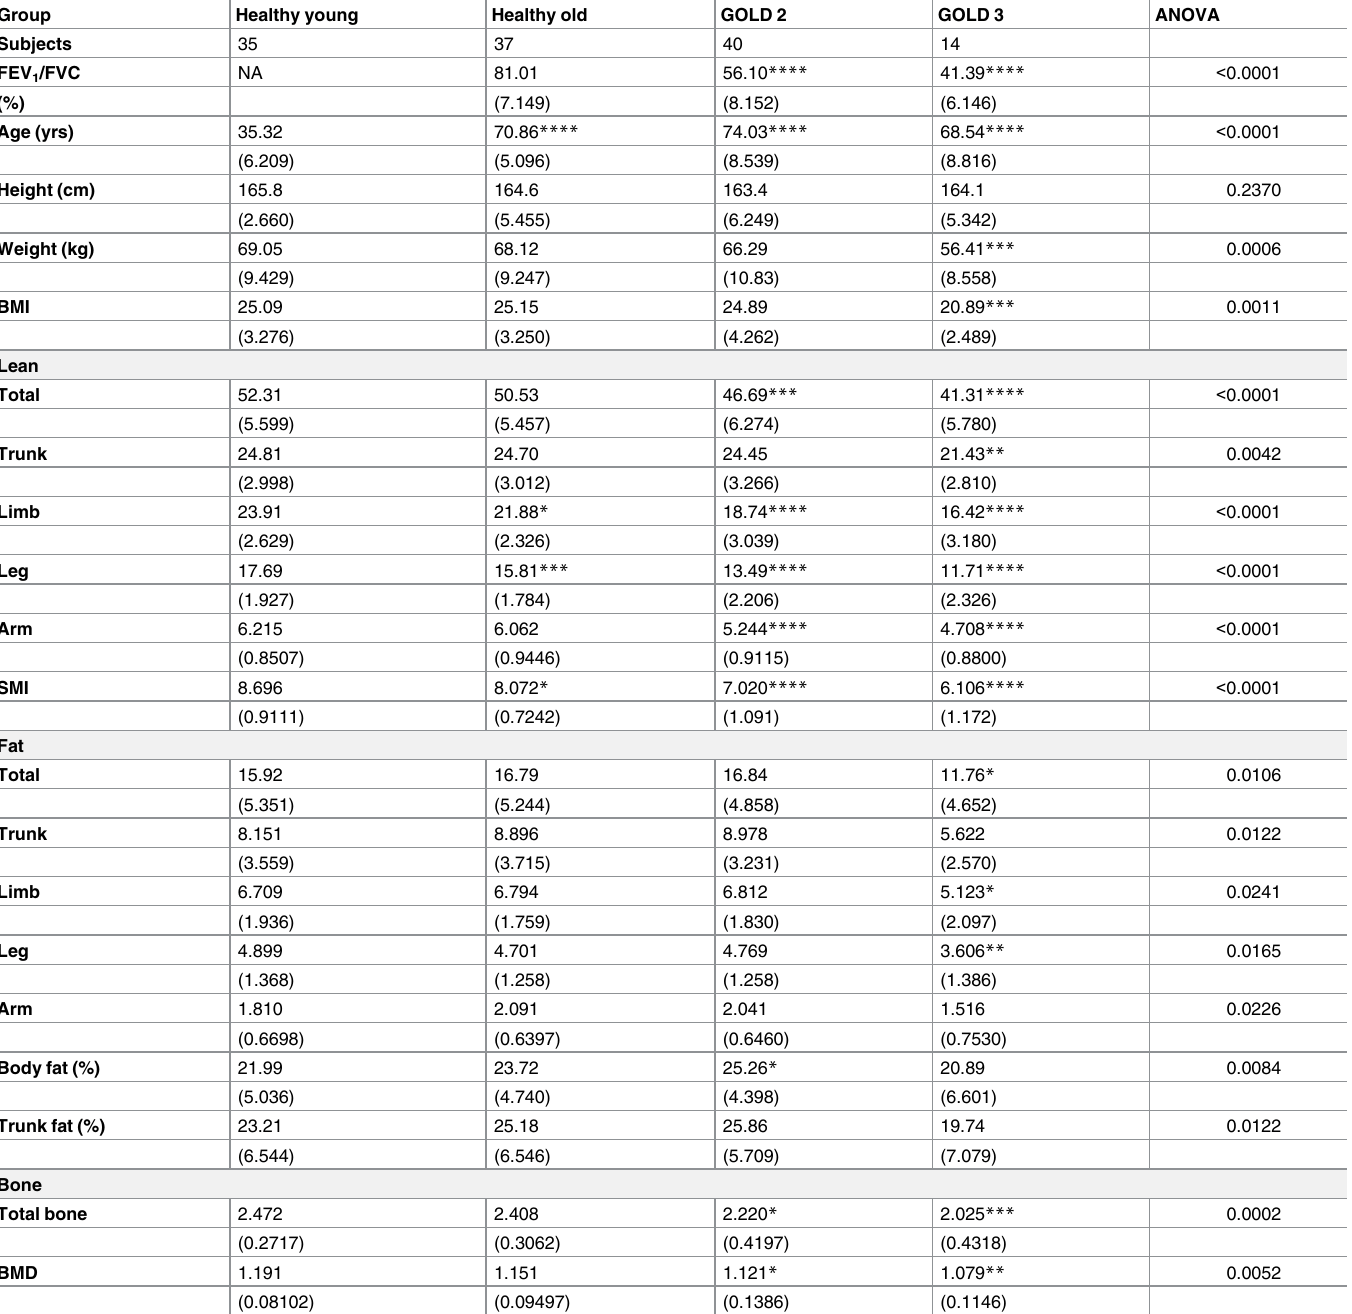
Table 1. Patient